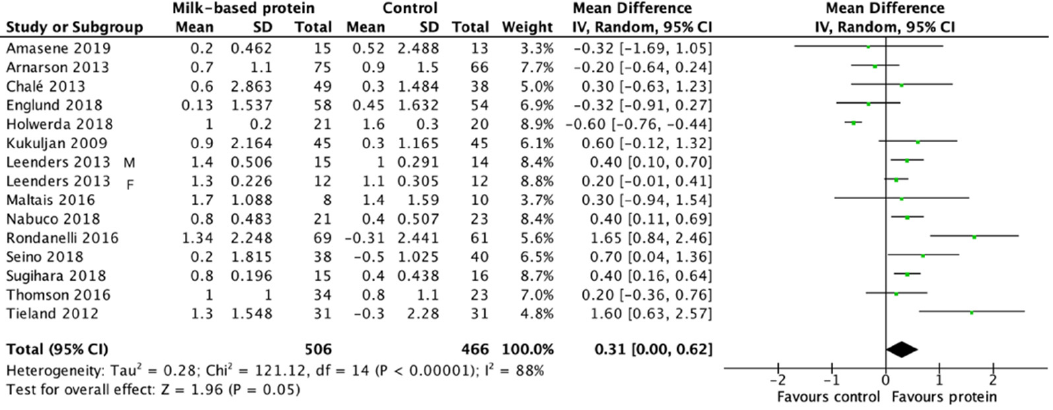
Figure 3. Forest plot for the differences in RT-induced LBM/FFM gain between consuming milk-based protein supplements and control supplements above age 60 years.